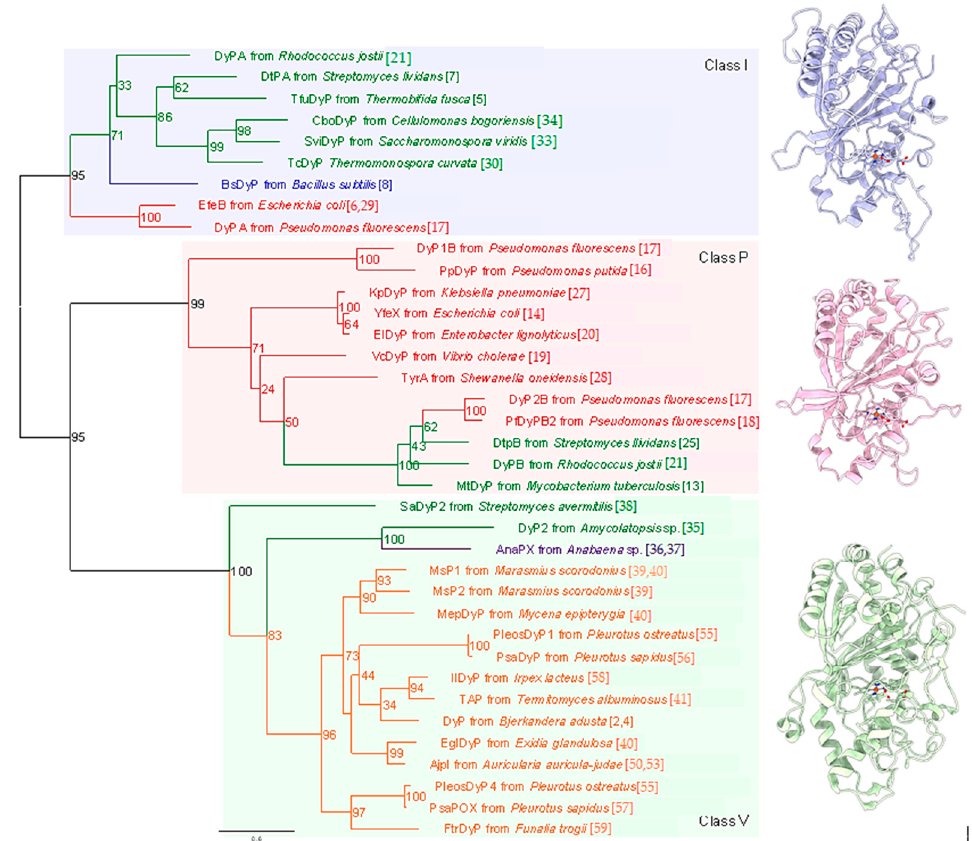
Figure 1. DyP phylogenetic tree. The tree was constructed with the maximum-likelihood method using RAxML-NG [61] with multiple sequence alignments of DyP amino acid sequences generated by the MAFFT [62] program. Percentages of bootstrap values obtained from 1000 bootstrap replicates are shown at the nodes. The best-fit model of evolution of the alignment was determined using ModelTest-NG [63]. Branches and labels of different phyla are shown in different colors: green, actinobacteria; blue, firmicutes; red, proteobacteria; purple, cyanobacteria; orange, basidiomycota. Reference numbers for each DyP are shown in parentheses. Structures of representative DyPs of the three classes are shown on the right: Class I, DtPA (PDB ID: 6gzw); Class P, DtPB (PDB ID: 6yrj); Class V: DyP (PDB ID: